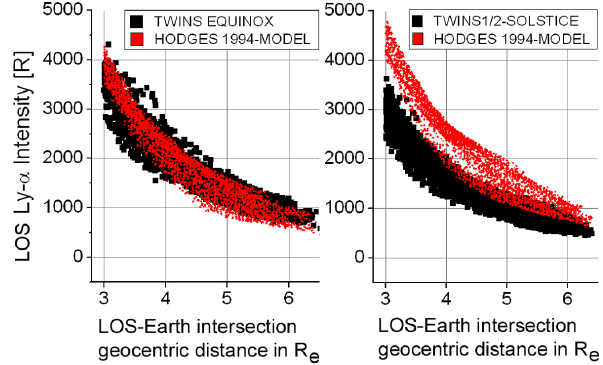
Fig. 12. TWINS1/2 equinox and summer-solstice dataset LAD- Lyman- α intensities in Rayleigh (black) in comparison to calcu- lated Lyman- α intensities from the Hodges (1994) H-density model ( F 10.7cm = 80 [10 − 22 Wm − 2 Hz − 1 ]